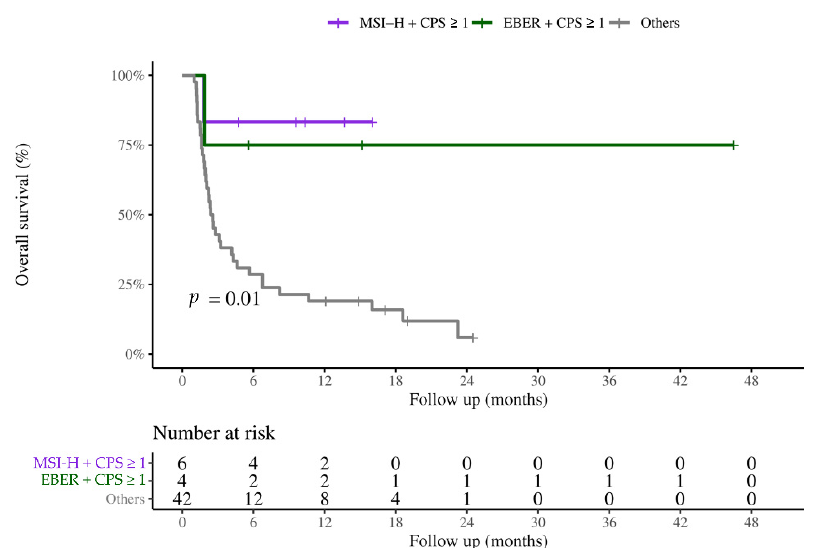
Figure 5. Survival curves of patients with combined biomarkers. EBER: Epstein–Barr virus-encoded small RNAs; MSI-H: high microsatellite instability; PD-L1: programmed death ligand 1; CPS: com- bined positive score.